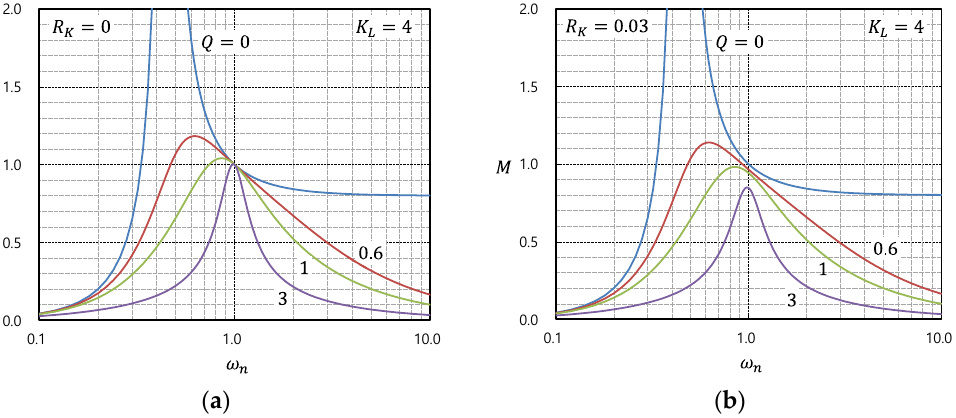
Figure 7. Frequency characteristics of DC voltage gain M for LLC resonant converter according to internal loss resistance 𝑅 𝐾 : ( a ) When the internal loss resistance 𝑅 𝐾 is 0; and ( b ) when 𝑅 𝐾 is 0.03.